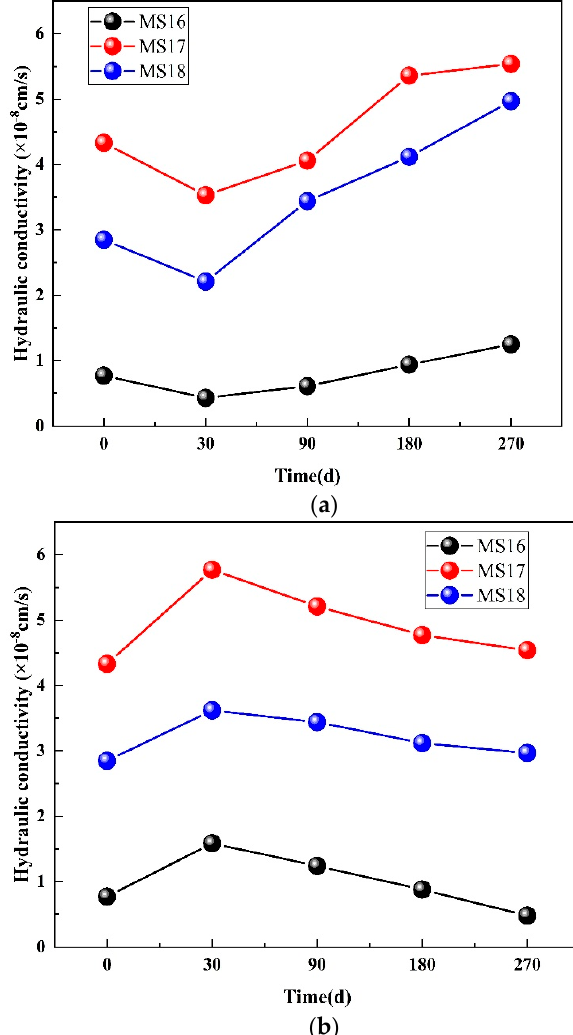
Figure 6. Hydraulic conductivity of MS16–MS18 samples exposed to air or immersed in water. ( a ) Exposed to air. ( b ) Immersed in